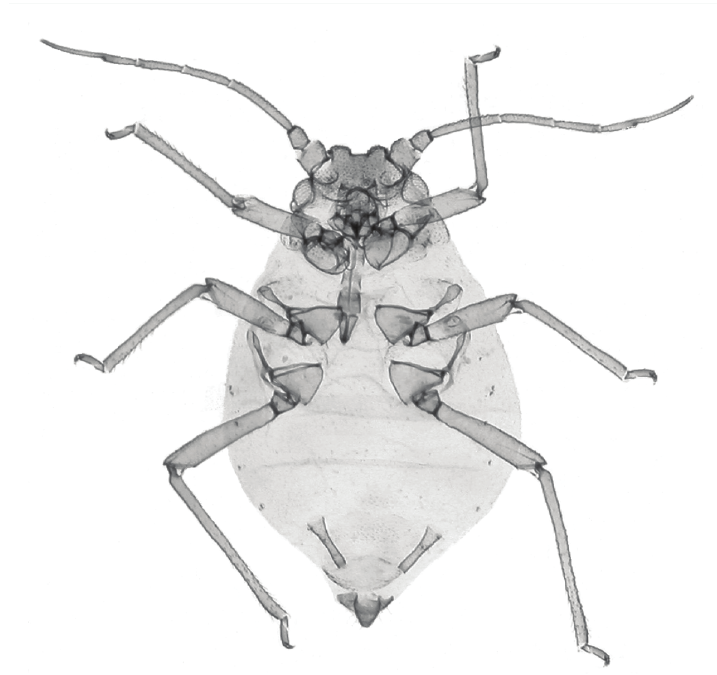
Fig. 11. Jacksonia papillata theobald, 1923 . Aptera (photo roger blackman, from blackman 2010, with license from the royal entomological